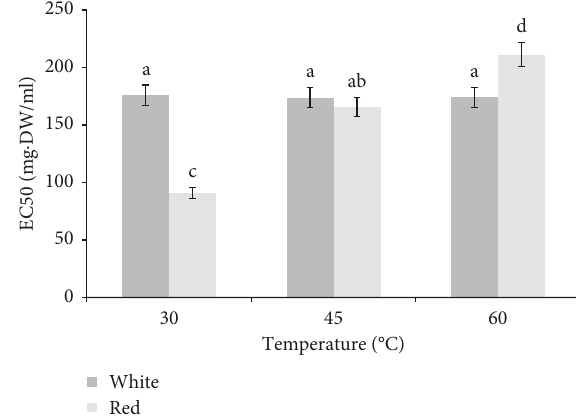
Figure 4: Comparison of ABTS radicals scavenging activity of red and white quinoa leaves